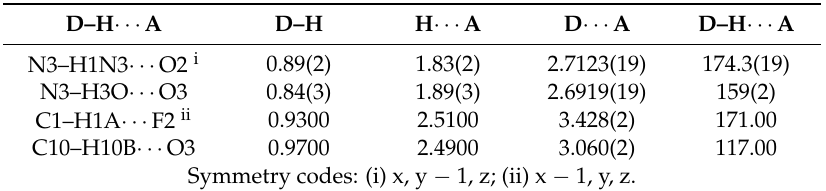
Figure 2. H-bonding network in the crystal structure of 3 viewed along the b and c axes, Dotted lines indicate intermolecular interactions. Table 3. Hydrogen-bond geometry (Å, °) of 3 .